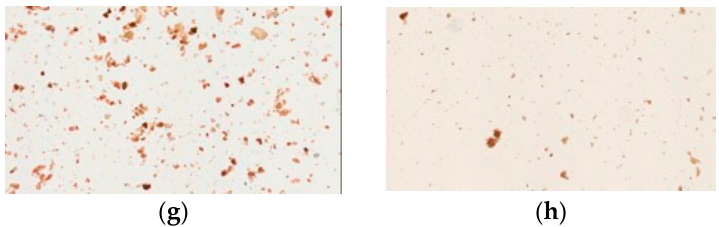
Figure 3. Light microscopy photographs of Congo red staining of Yin-Chen-Hao-Tang in preparations of pharmaceutical products: ( a – d ) products from brands A–D; raw herbal powders: ( e ) Artemisia capillaries Thunb; ( f ) Gardenia jasminoides Ellis; ( g ) Rheum officinale Baill; and ( h ) Yin-Chen-Hao-Tang decoction. Iodine forms an intense complex with glucose starch or glycogen to yield a blue color. Cornstarch, a source of glucose, is easily stained by iodine solution. Our physical examination showed that all samples of pharmaceutical products had dark blue or purple color under the light microscope, similar to cornstarch. In contrast, the raw fiber powders of each herb in Yin-Chen-Hao-Tang and the decoction gave no blue color (Figure 4).